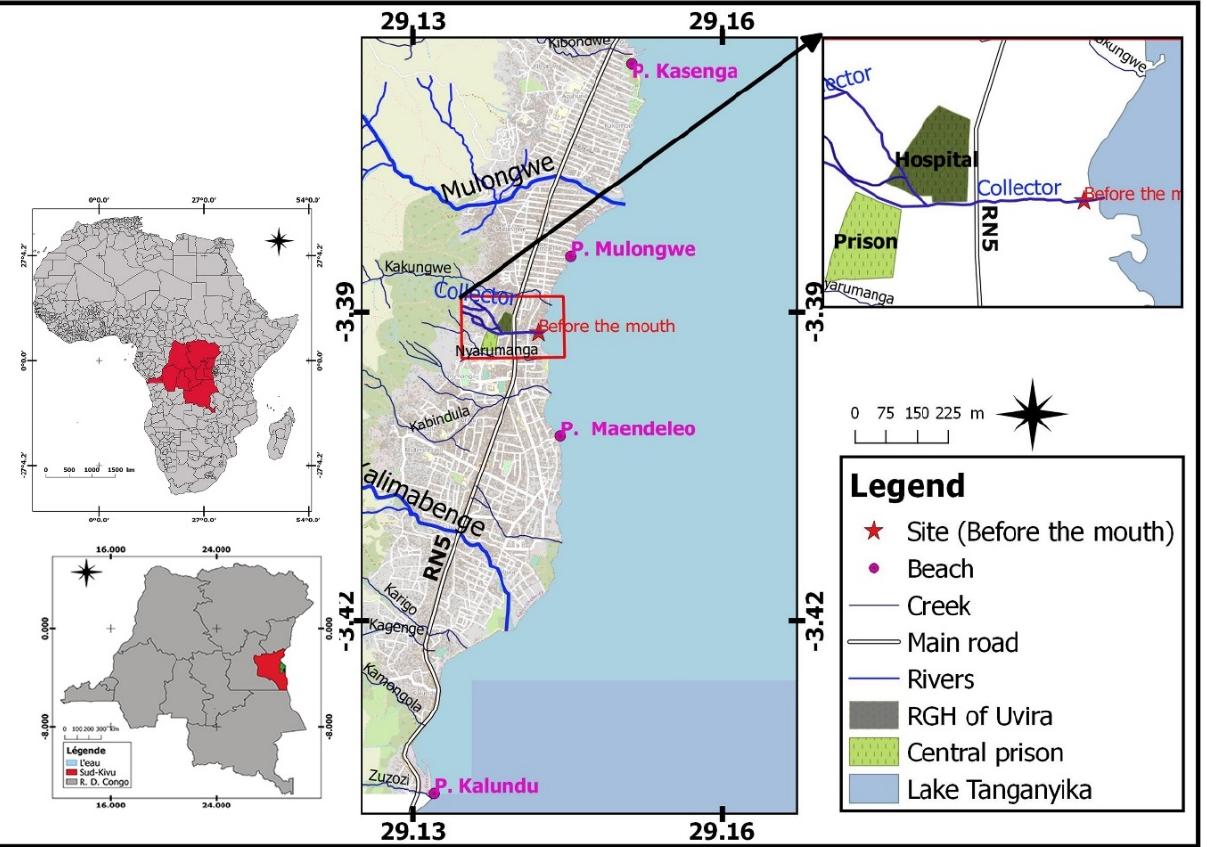
Figure 1. Location of sampling